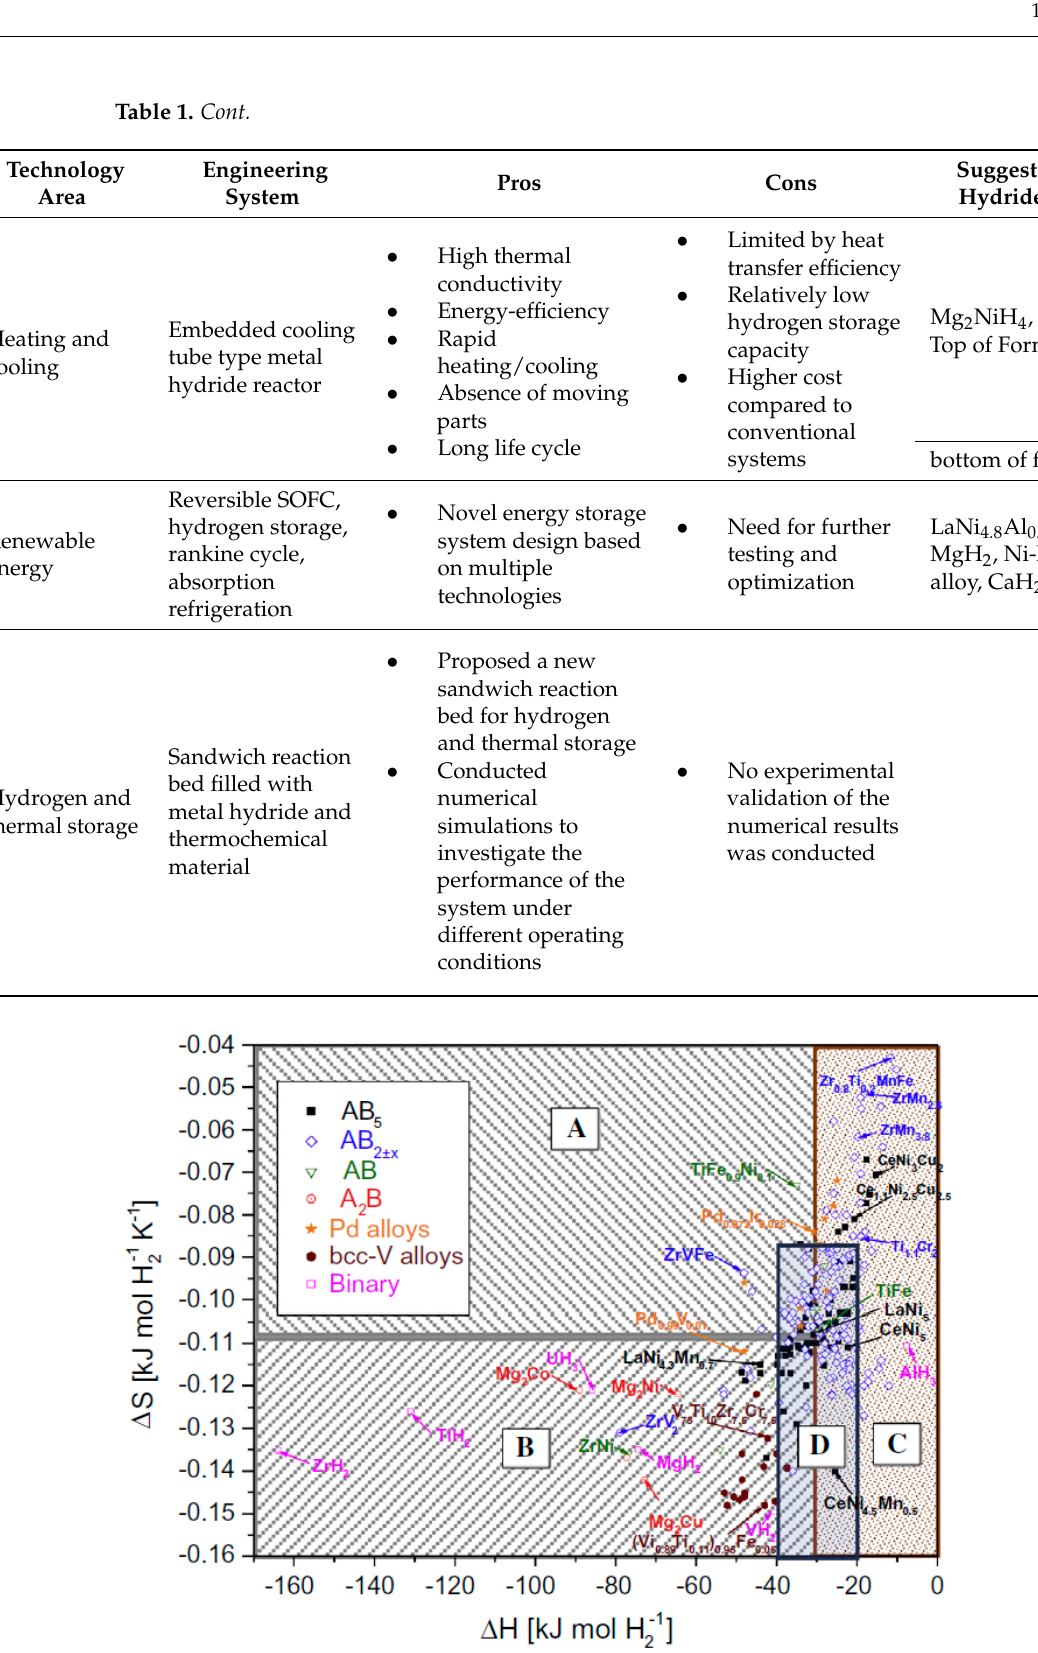
Figure 1. Hydrogenation enthalpies and entropies of various hydride materials and their suitable applications: ( A ) heat pumps, ( B ) heat storage, ( C ) hydrogen storage, ( D ) hydrogen compression [27]. Type AB 5 metal hydrides (for which LaNi 5 serves as the paradigm) and type AB 2